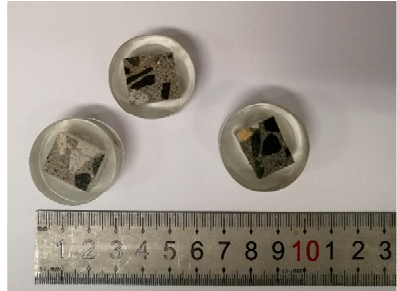
Figure 4. The samples for nanoindentation test. Materials 2020 , 13 , x FOR PEER REVIEW